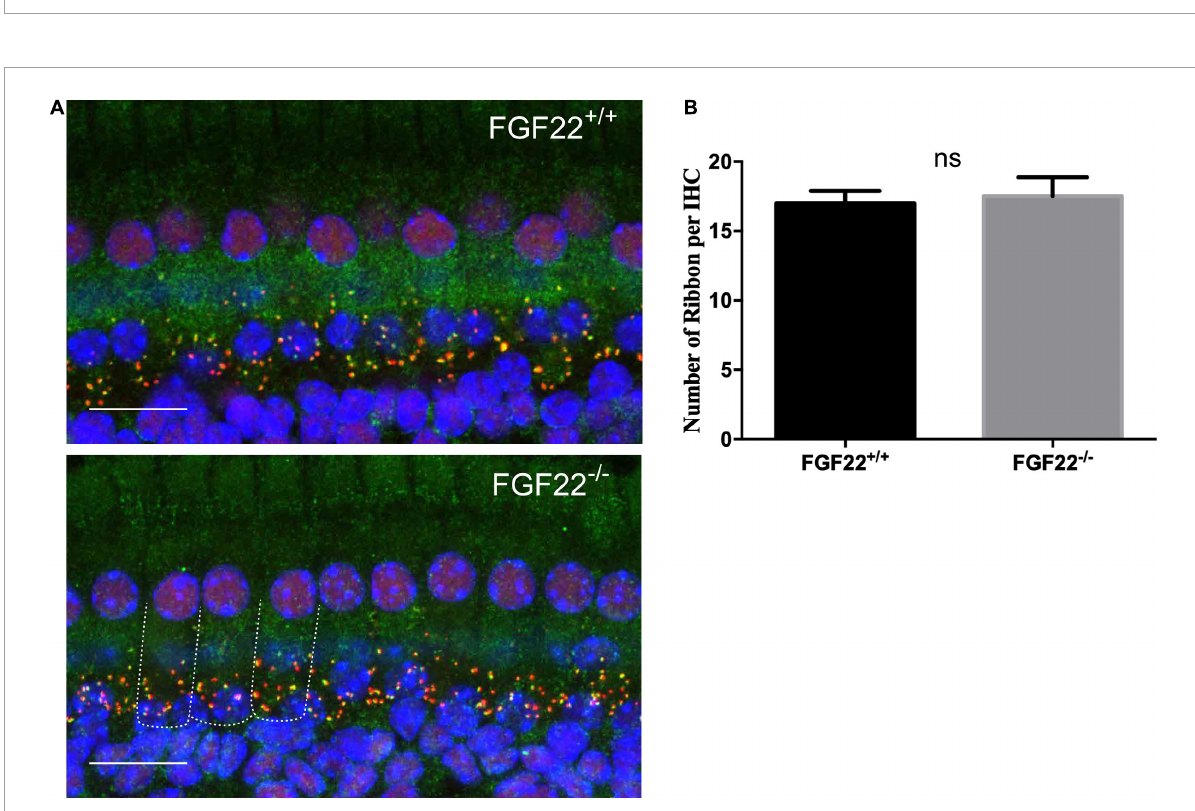
FIGURE3 The number of synaptic ribbons in Fgf22 + / + and Fgf22 − / − mice. (A) Representative cochlear whole-mount preparation ( n = 6, middle turn) images of CtBP2-labeled presynaptic ribbons (red) and GluR2-labeled postsynaptic glutamate receptors (green) from the Fgf22 + / + and Fgf22 − / − groups showing the overlapped puncta (yellow). Scale bars: 20 µ m. (B) The bar chart showed the number of synaptic ribbons per IHC, which was similar in the Fgf22 + / + and Fgf22 − / −